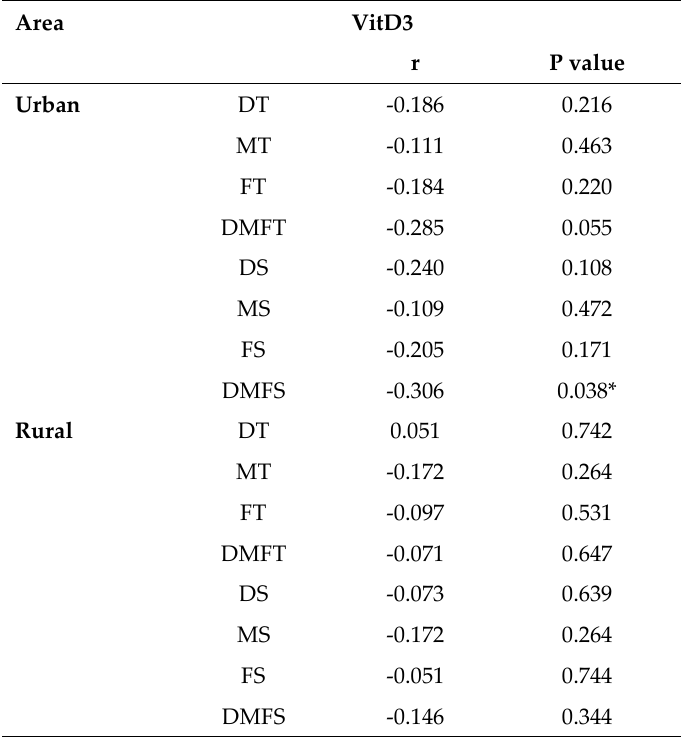
Table 6: Correlation between dental caries experience by teeth, dental caries experience by surfaces and Sali- vary vitamin D3. Area VitD3 r P value Urban DT -0.186 0.216 MT -0.111 0.463 FT -0.184 0.220 DMFT -0.285 0.055 DS -0.240 0.108